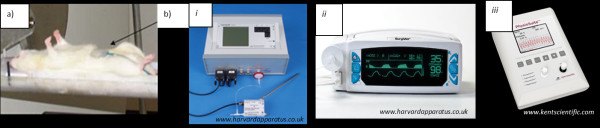
 Image displaying some of examples of respiratory monitoring equipment. (a) Respiratory sensor (VioHealthcare, Uckfield, UK); (b) Capnographs used for rodents: (i) type 340 Capnograph system (Harvard Apparatus, Holliston, MA, USA) with specifications for working with mouse or rats; (ii) MRI adaptable system: V9004 Capnography/Pulse oximeter (Harvard Apparatus); and (iii) PhysioSuite (Kent Scientific Corporation, Torrington, CT, USA) CapnoScan to measure the end tidal CO2.